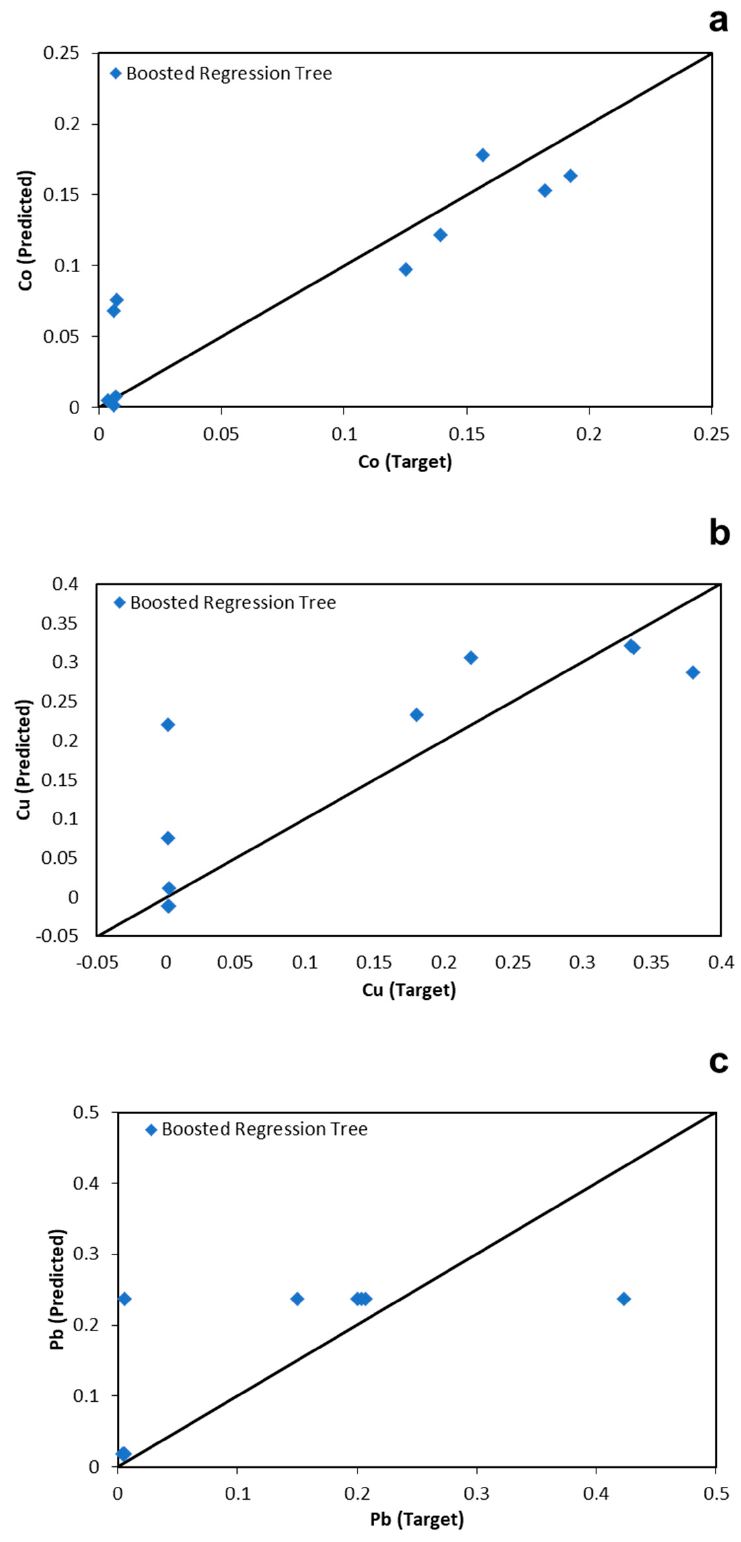
Figure 9. Scatter plot of target vs. predicted Co ( a ), Cu ( b ) and Pb ( c ) using the boosted regression tree method in validation stage.